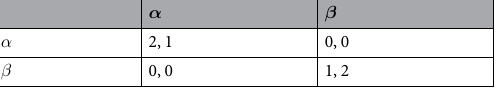
Table 1. Payoff table of an asymmetric coordination